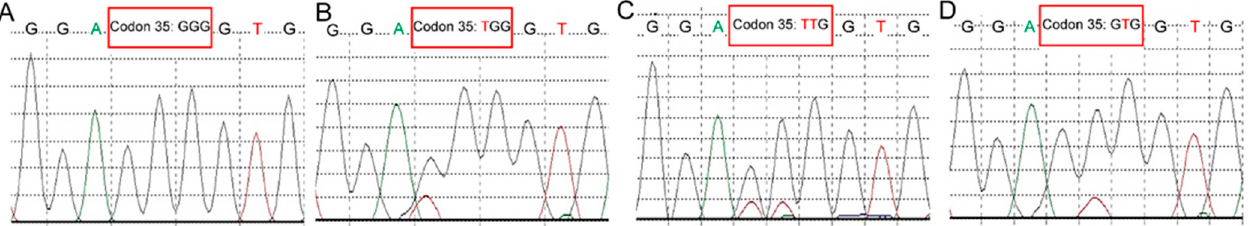
Figure 1. H3-3A gene mutations in giant cell tumour of bone (GCTB). ( A ) nucleotide sequence in wild-type H3-3A gene; ( B ) p.Gly35Trp (G35W) mutation resulting from c.103G>T substitution in codon 35; ( C ) p.Gly35Leu (G35L) substitution caused by c.103_104delinsTT mutation in codon 35; ( D ) c.104G>T variant mutation in codon 35 in case of p.Gly35Val (G35V) substitution.